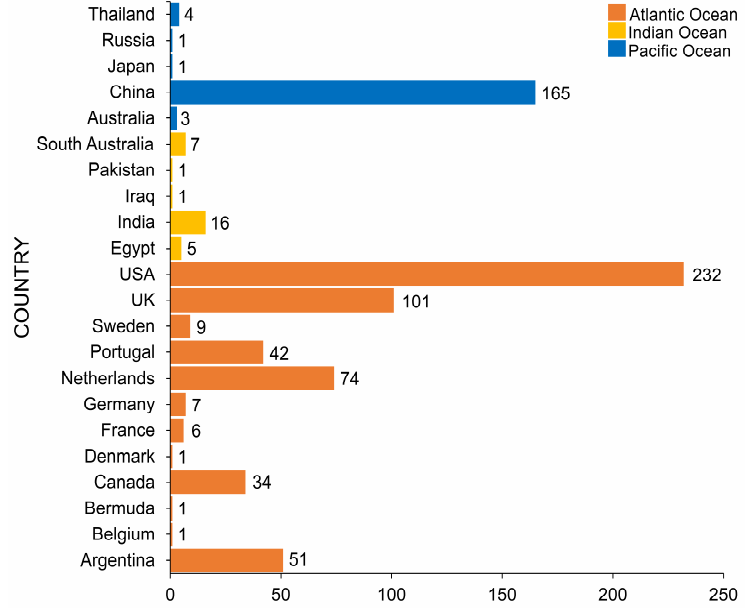
Figure 14. The number of salt marsh fungi reported in the Pacific, Atlantic, and Indian Oceans.